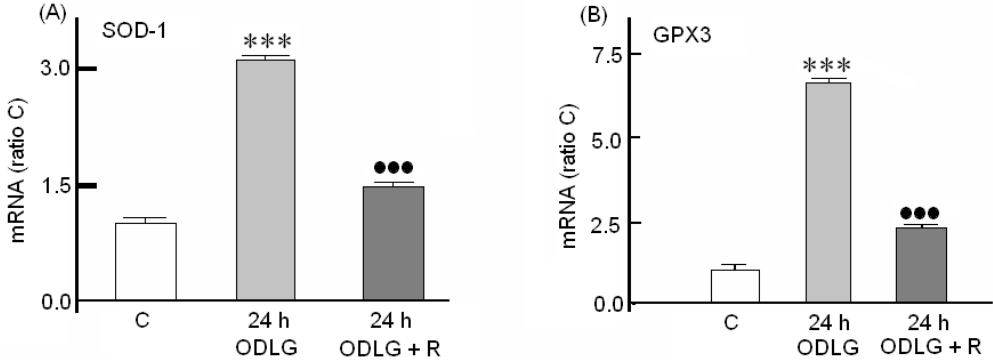
Figure 7. Effect of ODLG treatment on ( A ) SOD1 gene and ( B ) on GPX3 gene induction. ODLG = 24 h of ODLG exposure, ODLG + R = 24 h of ODLG exposure plus 24 h reperfusion. (***) ( vs. control) or ( ••• ) (ODLG vs . ODLG + R) = p < 0.005.